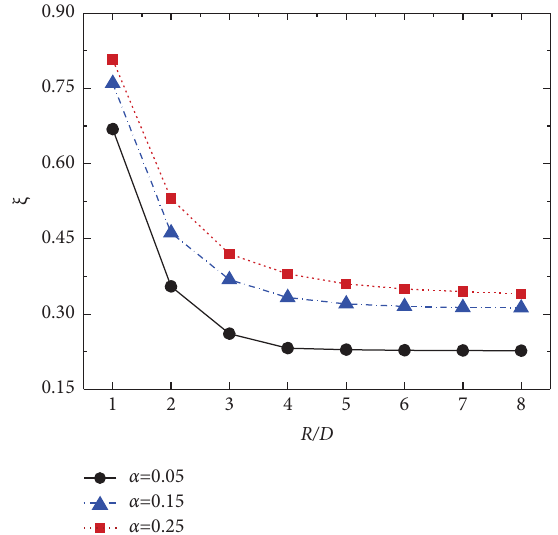
Figure 11: Relationship curves of ξ with R/D under diferent α in vertical Z-shaped